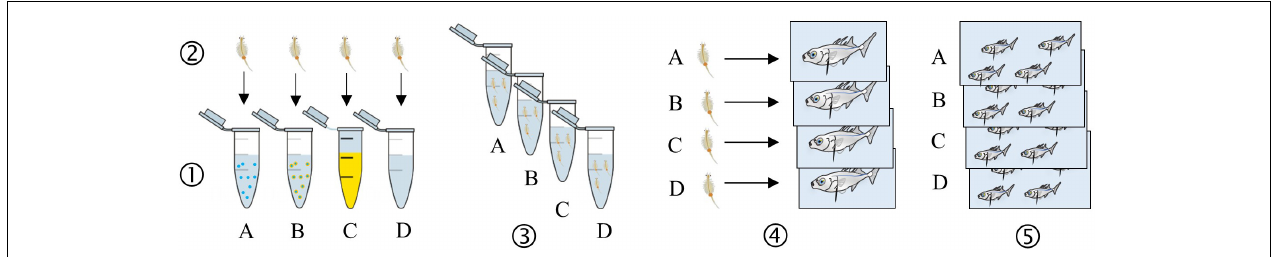
FIGURE 1 | Schematic representation of the exposure method. Colors, organisms and MPs numbers and size are not accurate. (1) Eppendorf ( n = 3) preparation for each condition: MPs in Artificial Sea Water (ASW) (A) , MP-CPF in ASW (B) , CPF in ASW (C) and control (ASW) (D) . (2) Artemia ( n = 15 per tube) are added and exposed for 15 min. (3) Exposure medium is removed and replaced by ASW to rinse Artemia (twice). (4) Artemia are fed to individualized fish (2–5 Artemia per fish. The number of Artemia increased over time, but was the same for every fish). (5) Fish belonging to the same exposure condition are grouped once all the Artemia have been ingested (eight fish per replicate, three replicates per